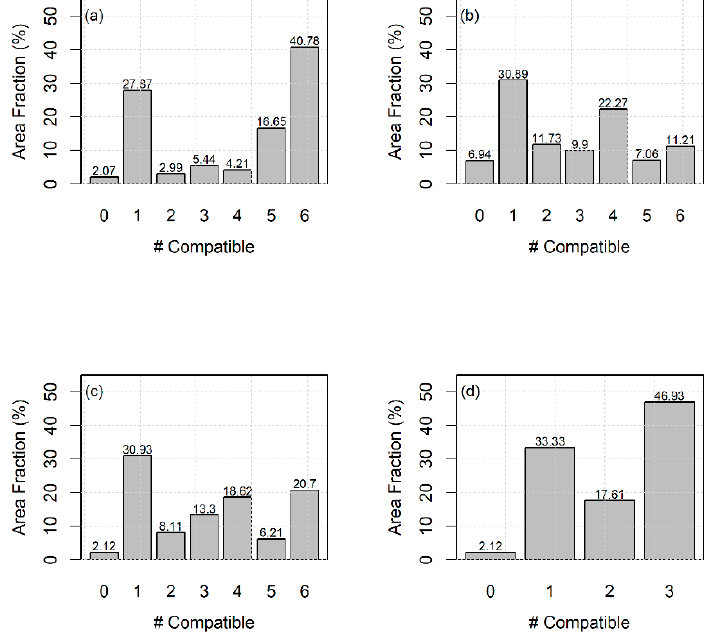
Figure 10. Area fraction of the number of compatible constituents within Dockum-HSU for agricultural water use—( a ) cotton, ( b ) corn, ( c ) sorghum, and ( d ) winter wheat.